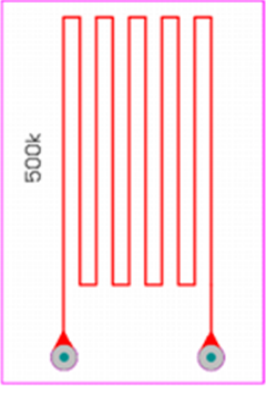
Figure 4. Schematic of the zigzag coil geometry.